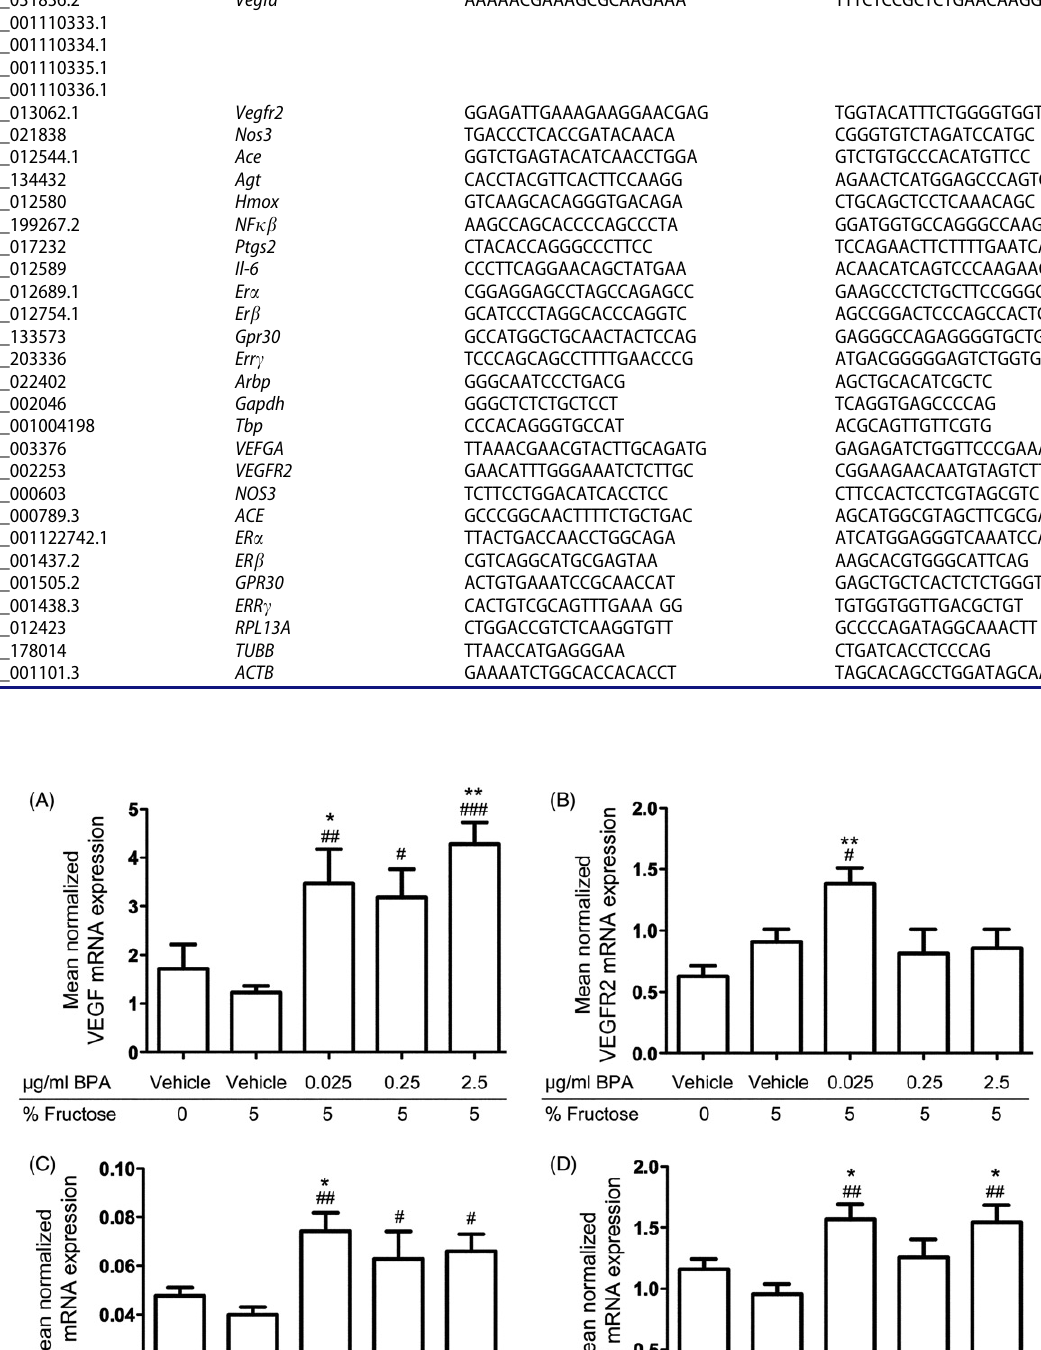
Table 2. The qRT-PCR primer sequences of genes included in the study. Accession no.